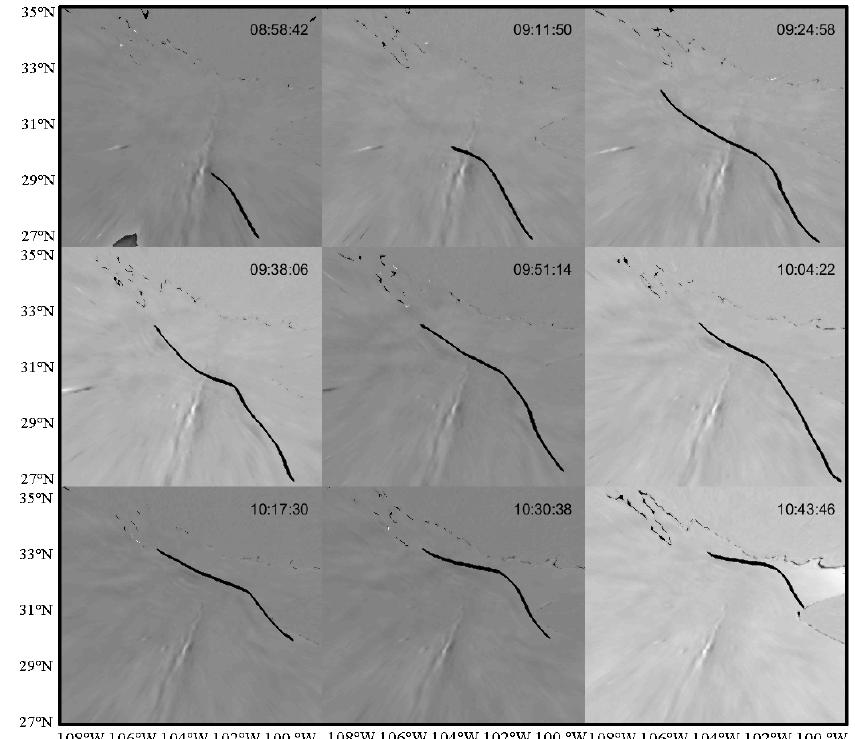
Figure 4. Time-difference OH images of the mesospheric bore event on 4 May 2014. The observation UT time is given at the top of each image. The black line indicates the front of the mesospheric bore. Bore propagation in the atmosphere is often supported by a temperature inversion layer [6–9].